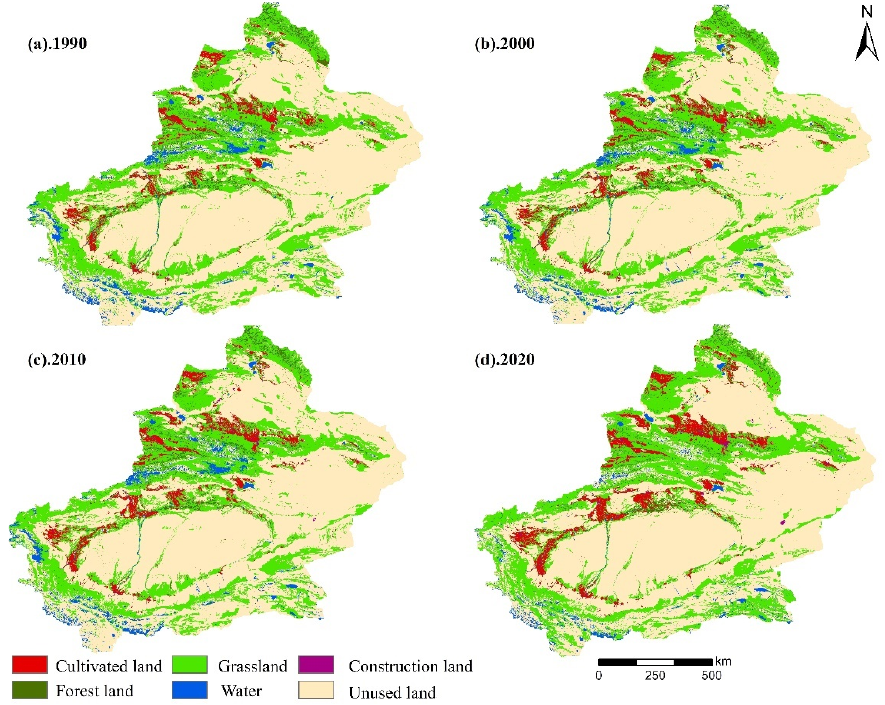
Figure 2. Land-use status in Xinjiang from 1990 to 2020. From 1990 to 2020, the land-use types in the study area showed different changes in different periods, which were mainly manifested as an increase in cultivated land and construction land area, and a decrease in forest and grassland, water, and unused land area. During the study period, the increase in cultivated land area was the most obvious, with a cumulative increase of 335.28 × 10 4 hm 2 over the past 30 years (Table 3). The growth rate was the fastest from 2010 to 2020, with a dynamic attitude of 3.10. This change was mainly caused by the conversion of grassland (286.31 × 10 4 hm 2 ) and unused land (104.43 × 10 4 hm 2 ), and the cultivated land area increased, to a certain extent, due to the reclama- tion and protection of wasteland. The total growth rate of construction land was 86.37 × 10 4 hm 2 during the study period, which showed the fastest growth rate from 2010 to 2020, and a dynamic attitude of 7.37, mainly from cultivated land (29.30 × 10 4 hm 2 ), unused land (20.08 × 10 4 hm 2 ), and grassland (16.16 × 10 4 hm 2 ). Unused land was the largest land-use